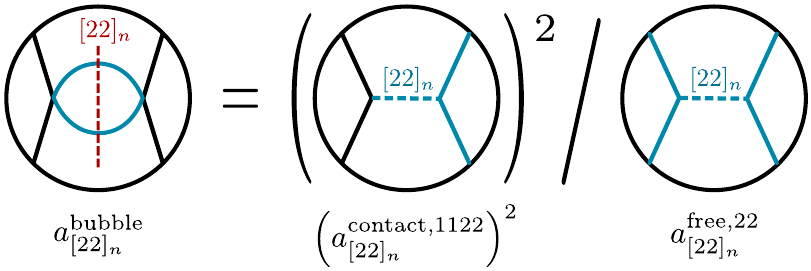
Figure 7 . The OPE coefficients of the double trace operators [22] n appearing in the s -channel bubble diagram can be extracted from the ones appearing in the conformal block expansion of the Witten contact diagram a contact,1122 and a free,22 as [22] n [22] n